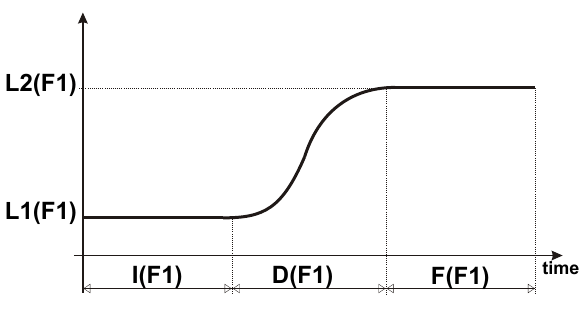
Figure 3. F1 transition trajectory example.